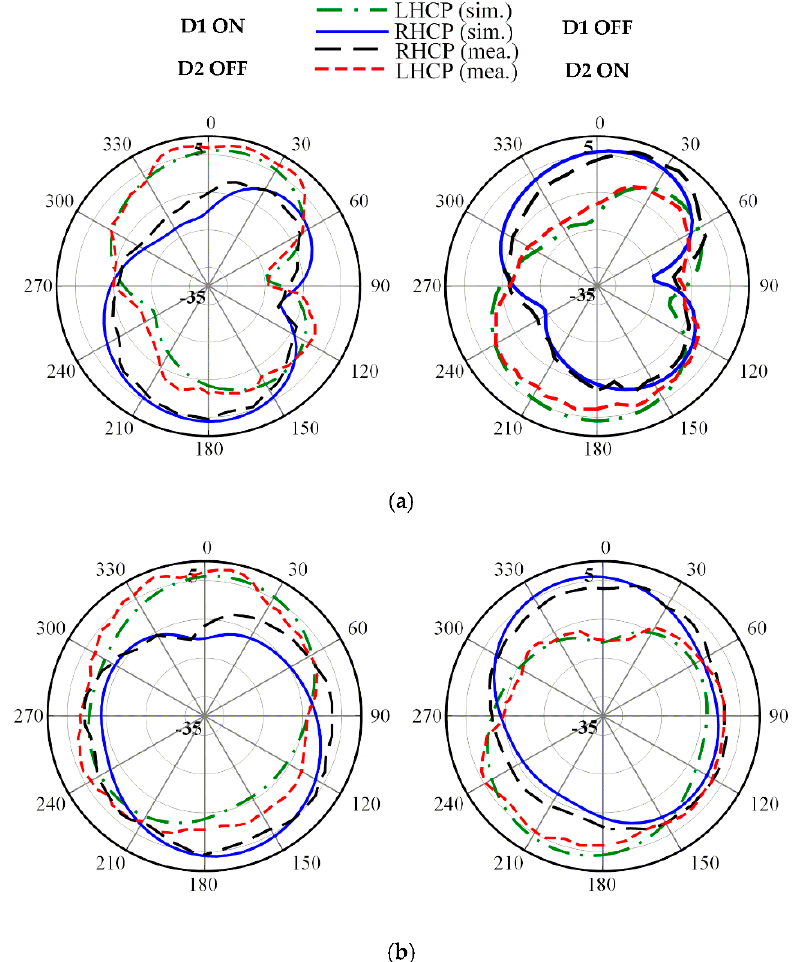
Figure 14. Measured radiation patterns at 3.8 GHz on: ( a ) x - z plane; ( b ) y - z plane.